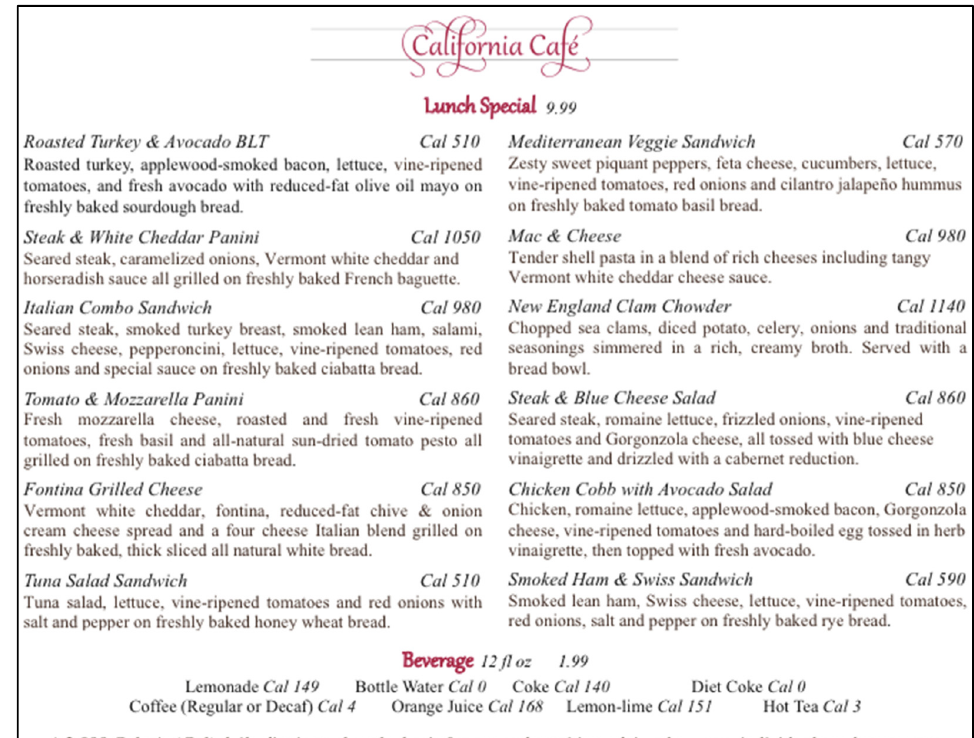
Figure A7. California Cafe Sweet Spot Menu.